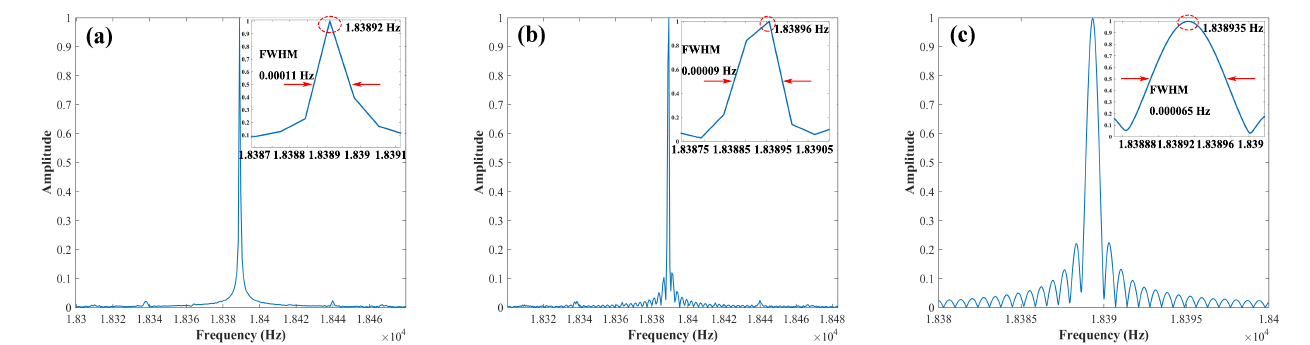
Figure 6. The comparison between FFT and CZT, ( a ) FFT of resampling beat signal without zero padding, ( b ) FFT of resampling beat signal with zero padding, ( c ) CZT of resampling beat signal.